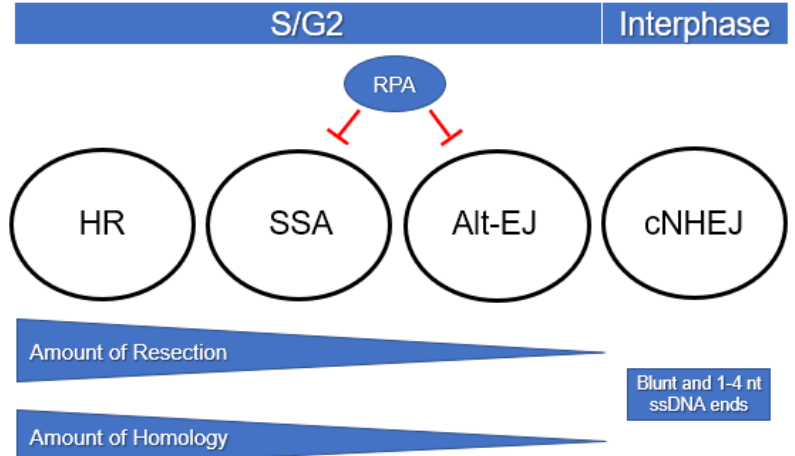
Figure 3. Factors that influence DSB repair pathway choice. cNHEJ operates throughout the cell cycle. HR, SSA, and alt-EJ require DNA resection and are therefore utilized primarily in S / G2. The required amounts of resection and homology are highest for HR and decrease for SSA and alt-EJ. RPA inhibits SSA and alt-EJ by preventing annealing of complementary sequences in single-stranded DNA.